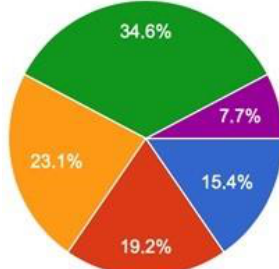
Figure 3. Extent of portal system involvement.